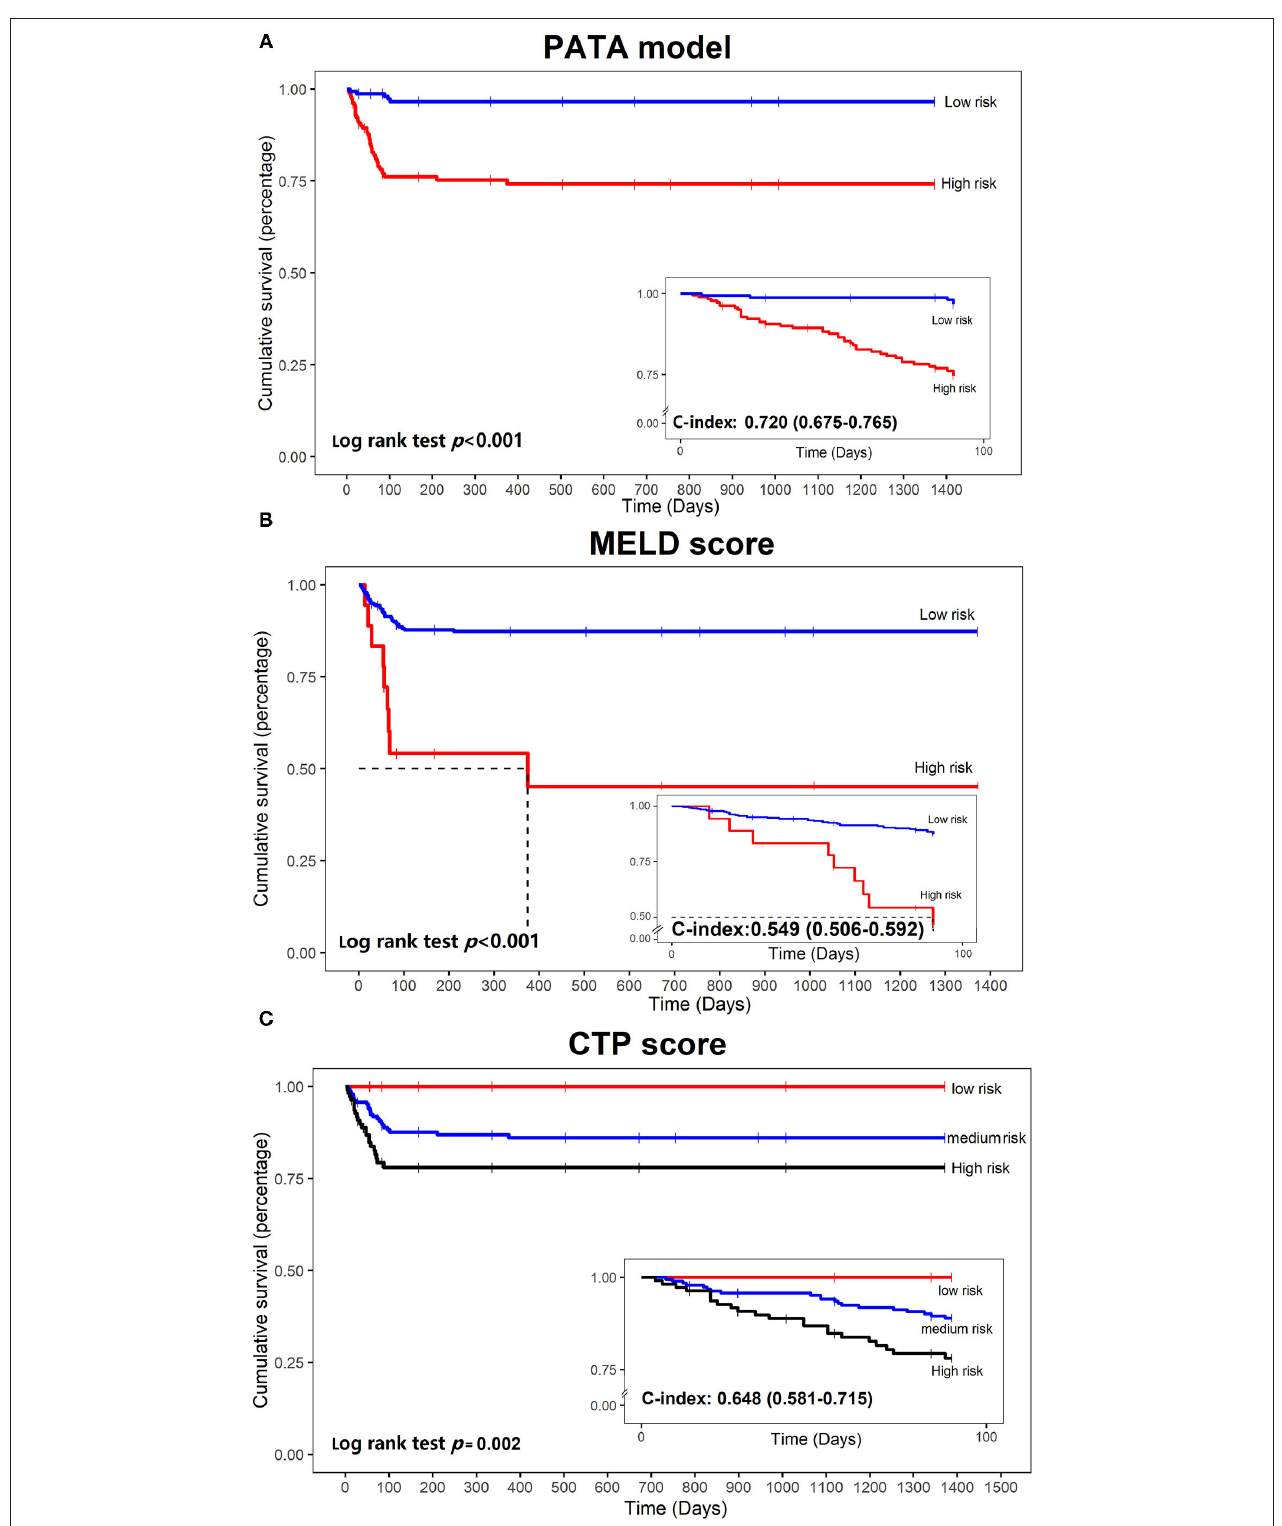
FIGURE 5 | Kaplan–Meier curves of mortality curves according to the different risks of liver failure. (A) PATA model; (B) model for end-stage liver disease (MELD) score; (C) Child–Turcotte–Pugh (CTP) scoring system.